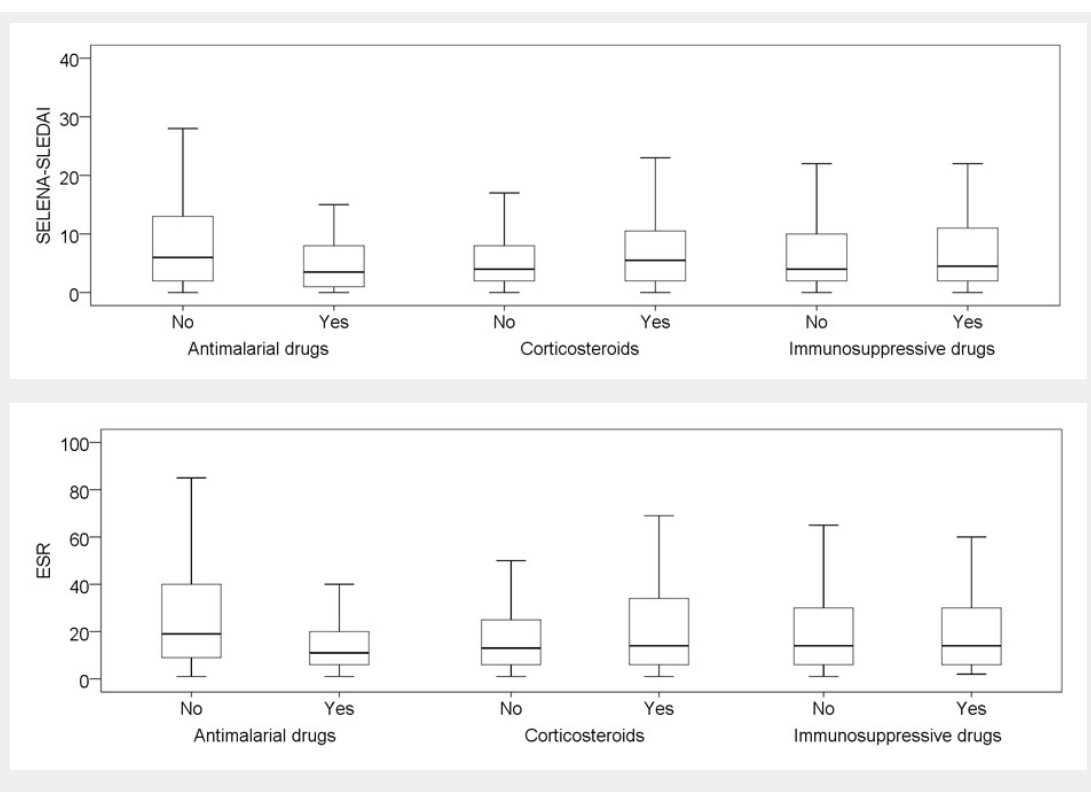
Figure 2 Disease activity in relation to treatment preceding visit (past month and before). A: SELENA-SLEDAI score at study visit. Differences are statistically significant for antimalarial drugs (p <0.001) and corticosteroids (p = 0.024). B: Erythrocyte sedimentation rate at study visit, in millimeter 1 st hour. Differences are statistically significant for antimalarial drugs (p =